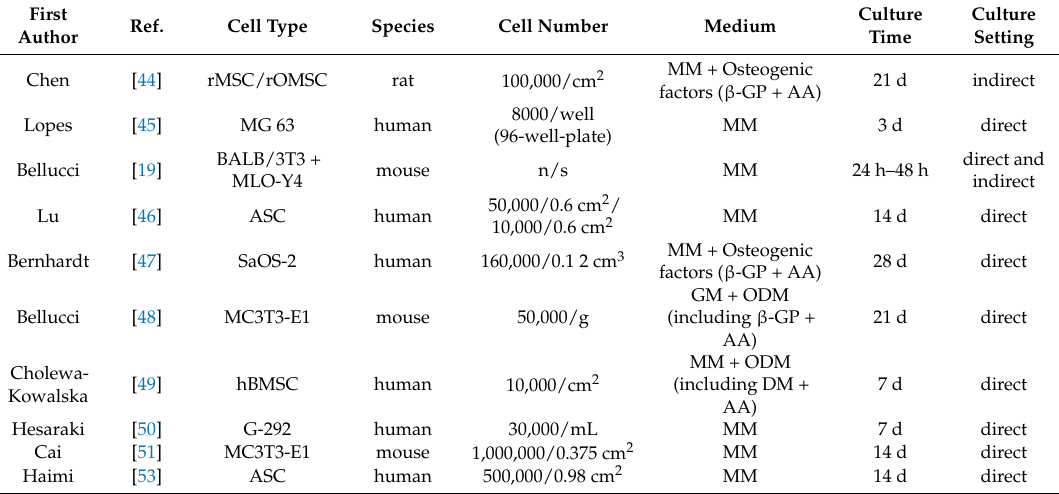
Table 2. In-vitro evaluation, study